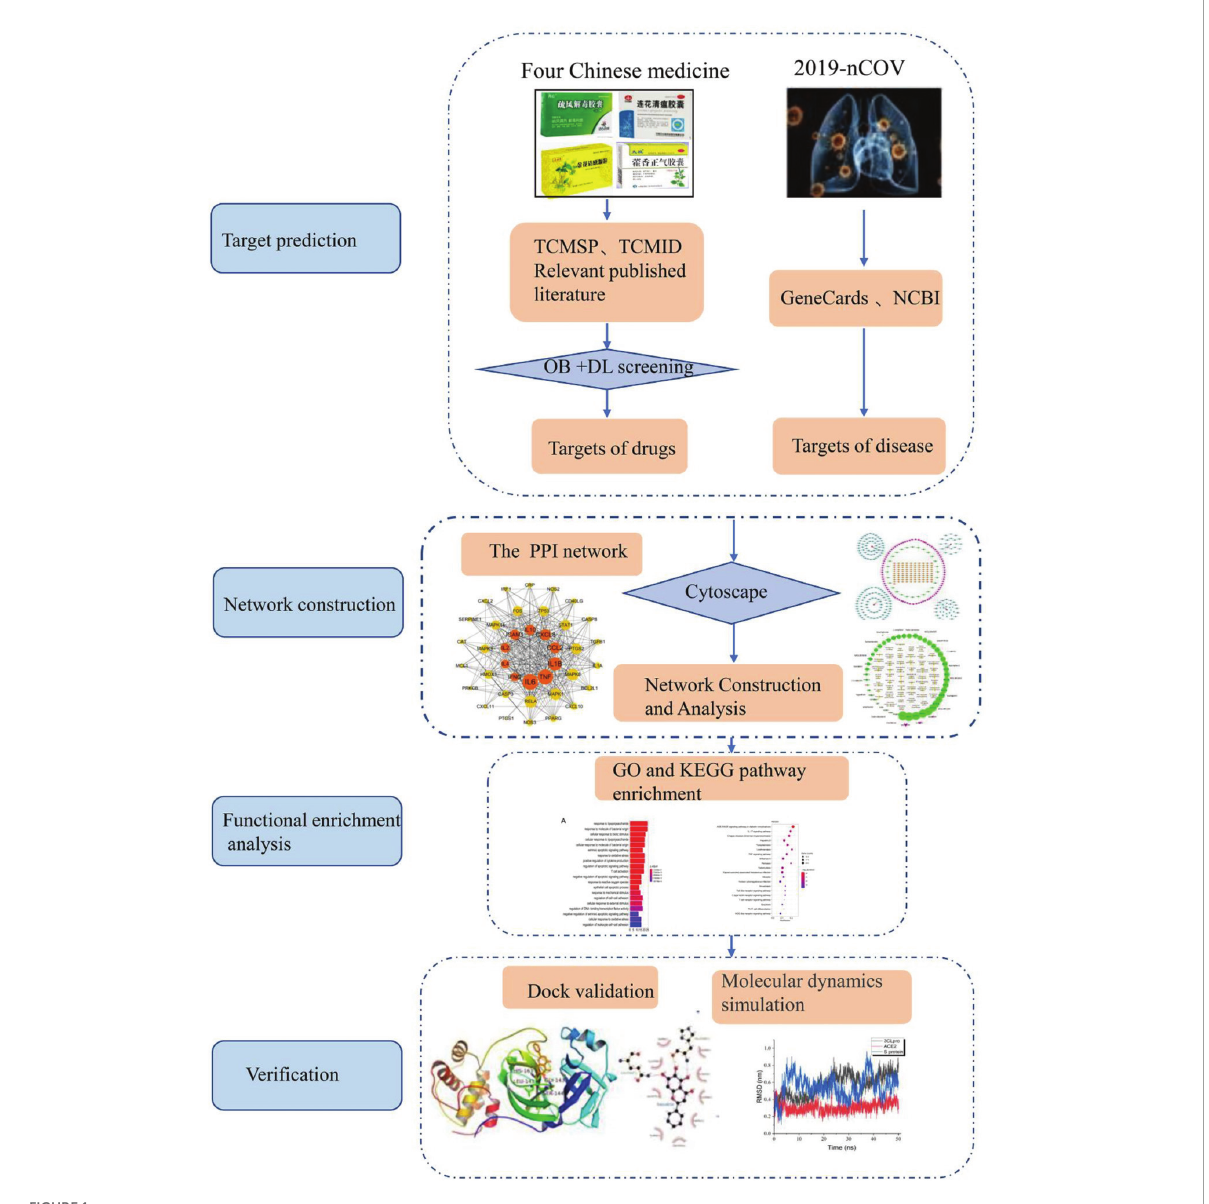
FIGURE1 The workflow of this whole analysis for this study.